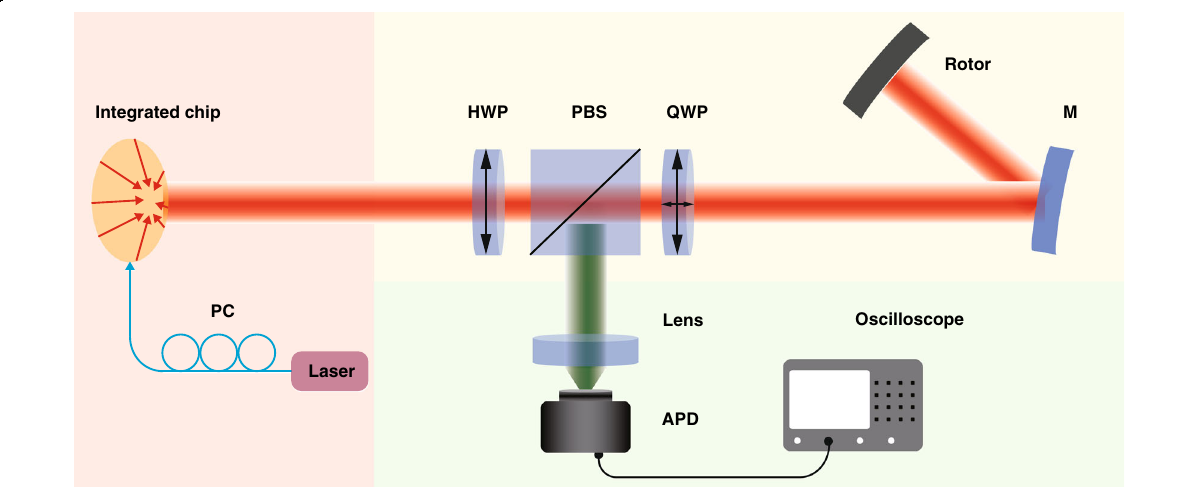
Fig. 3 Schematic diagram for experimental setup of rotation-speed measurement of a spinning object using the BGb generated by the Grating arrays-based photonic chip. It consists of three sections. Source section: the tunable laser passes through the polarization controller (PC), lens fi ber, and enters the chip to generate the BGb; Transmission section: BGb passes through half-wave plate (HWP), polarization beam splitter (PBS), quarter wave plate (QWP) sequentially, and is irradiated onto the surface of a rotating object through a mirror; Detection section: the echo with information enters Avalanche photodiodes (APD) through a plan convex lens with a focal length of 30 mm and fi nally enters the oscilloscope. The distance between the chip and the mirror is 1.4 m, and the rotor is an optical chopper without blades of which rotation speed can be accurately